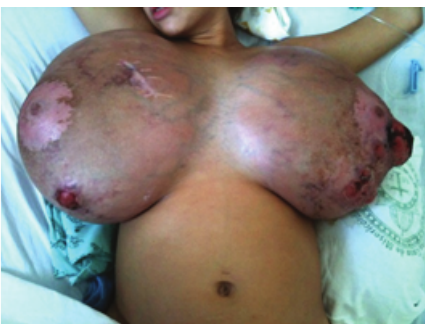
Figure 1: Patient in the 28th week of pregnancy. Note the excessive breast volume that prevented her from moving around or changing position in bed, causing extreme